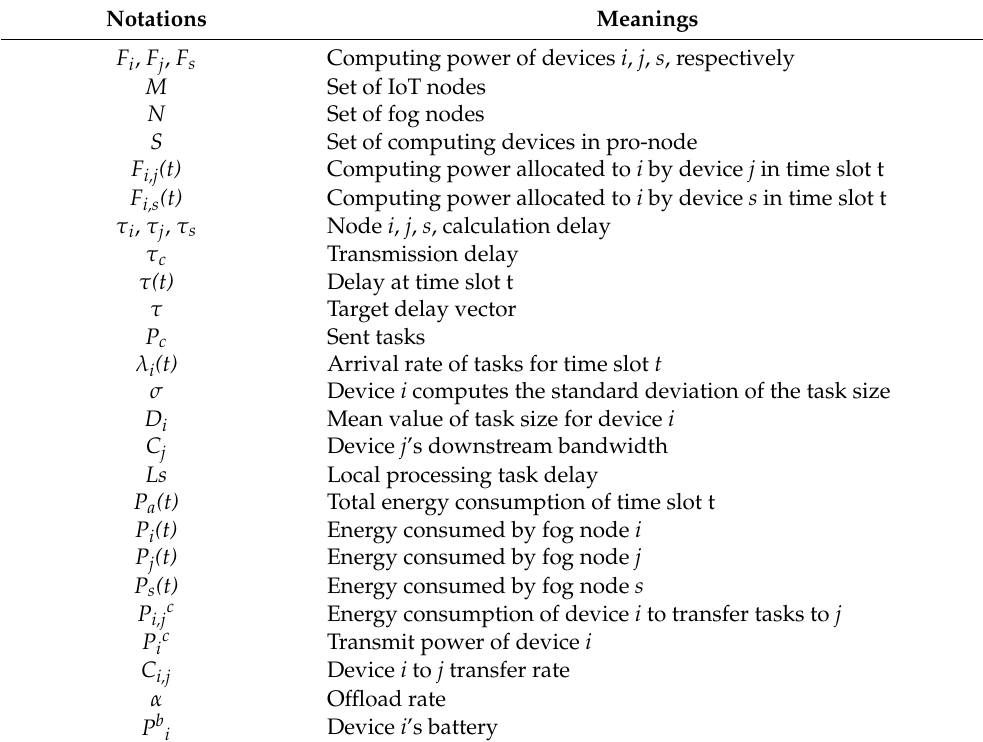
Table 1. Defitions of notations.